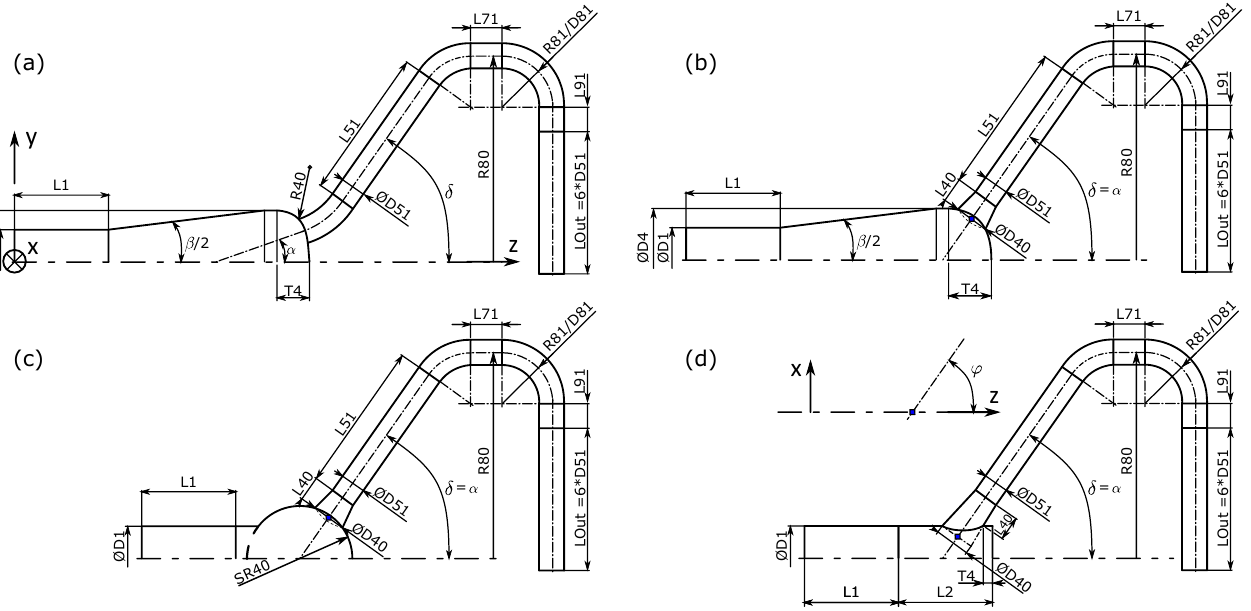
Figure 3. Sketch of the four basic investigated manifold designs: ( a ) basic model (for mesh and sym- metry study), ( b ) basic model with conical frustum, ( c ) spherical manifold, ( d ) cylindrical